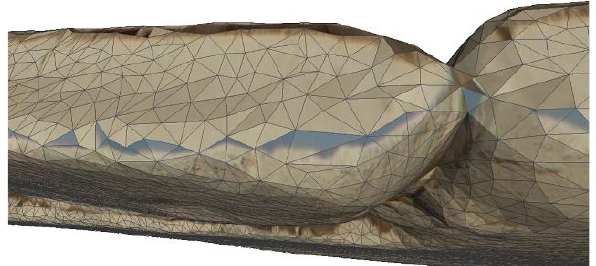
Figure 9. Problem case – colour gradients in the 3D model of the inscription stone